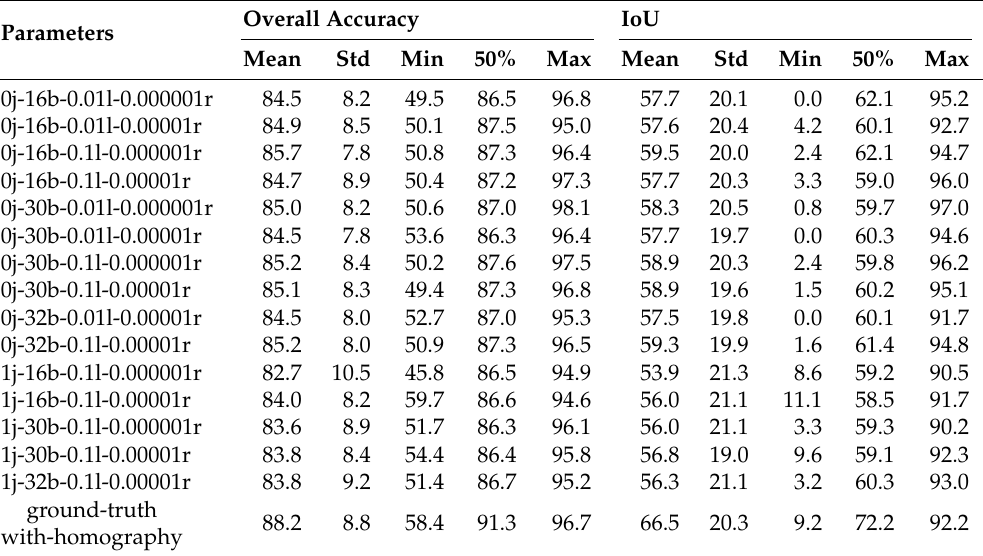
Table 3. Segmentation camera results on the ITESM dataset (14 + 62